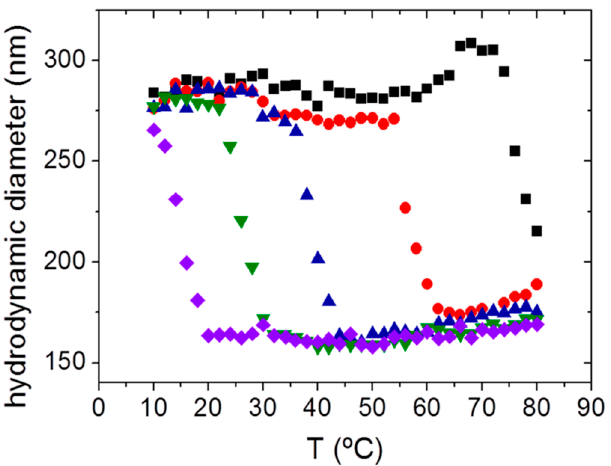
Figure 3. Average hydrodynamic particle size as a function of temperature at different pH and in a buffered solution (ionic strength of 150 mM). pH 6.0 ( ); pH 6.5 ( ), pH 6.9 (